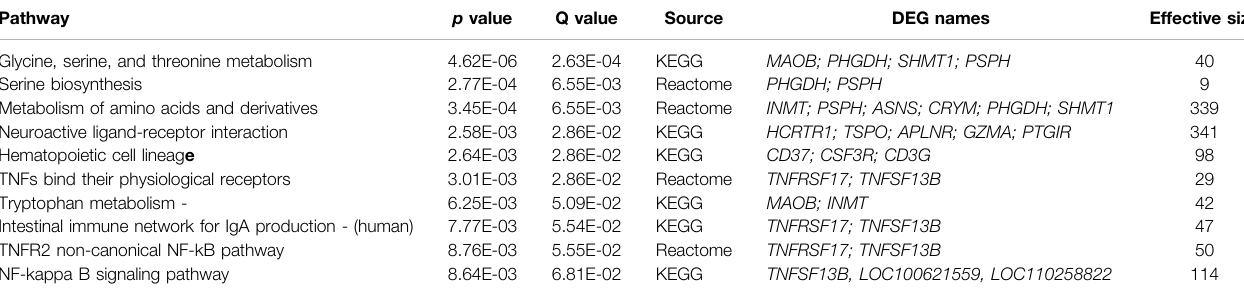
TABLE 2 | Top DEG Pathways in LPS/VILI-exposed pigs: ALT-100 mAb-treated versus PBS. Pathway Glycine, serine, and threonine metabolism